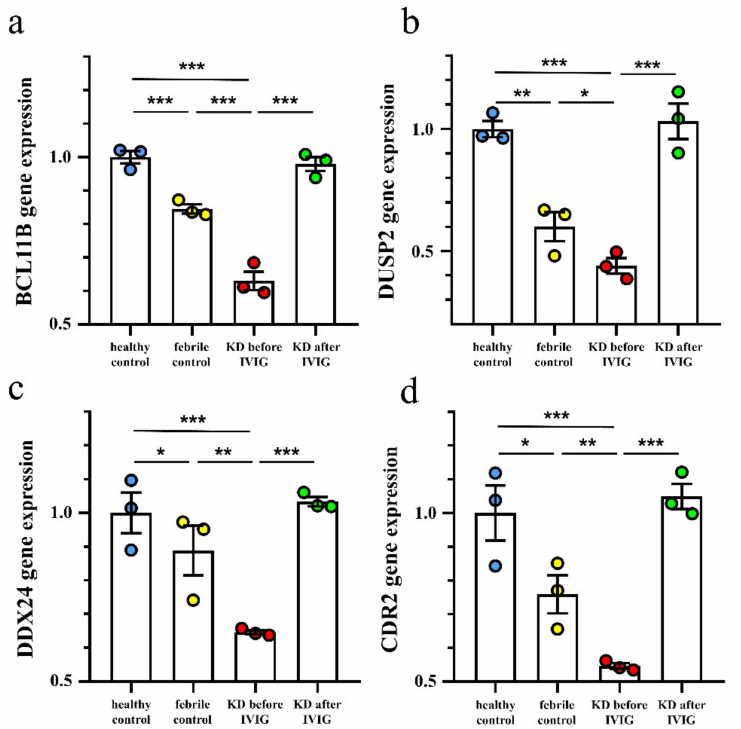
Figure 2. Comparison of BCL11B ( a ), DUSP2 ( b ), DDX24 ( c ), and CDR2 ( d ) expression determined by GeneChip ® Human Transcriptome Array 2.0 between acute-stage Kawasaki disease patients and control subjects. * Indicates significance ( p < 0.05), ** indicates significance ( p < 0.01). *** indicates significance ( p < 0.001). Data are expressed as mean ± standard error for the three